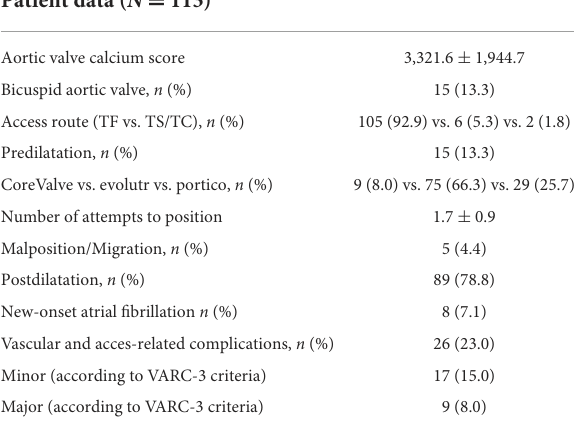
TABLE 1 Procedural